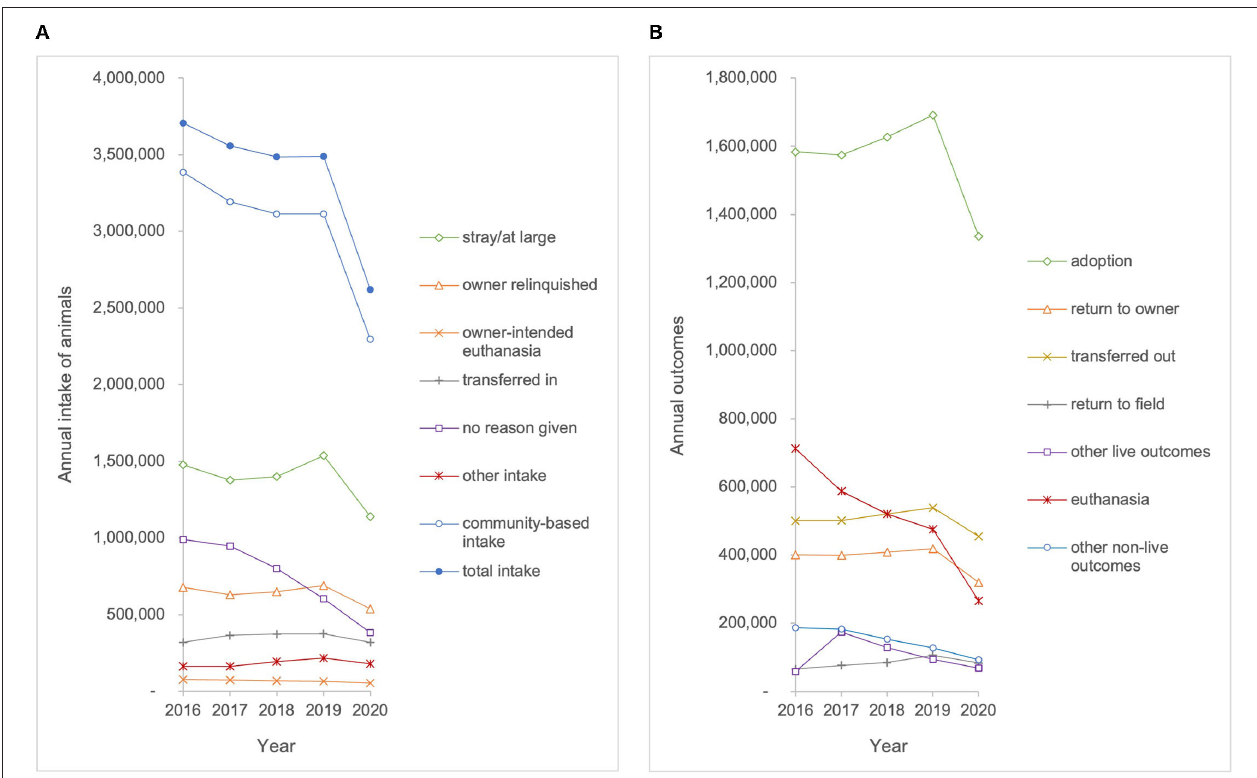
FIGURE 1 | (A) Annual intake and (B) annual outcomes for animals entering the shelters in the sample population ( n = 1,373) from 2016 to